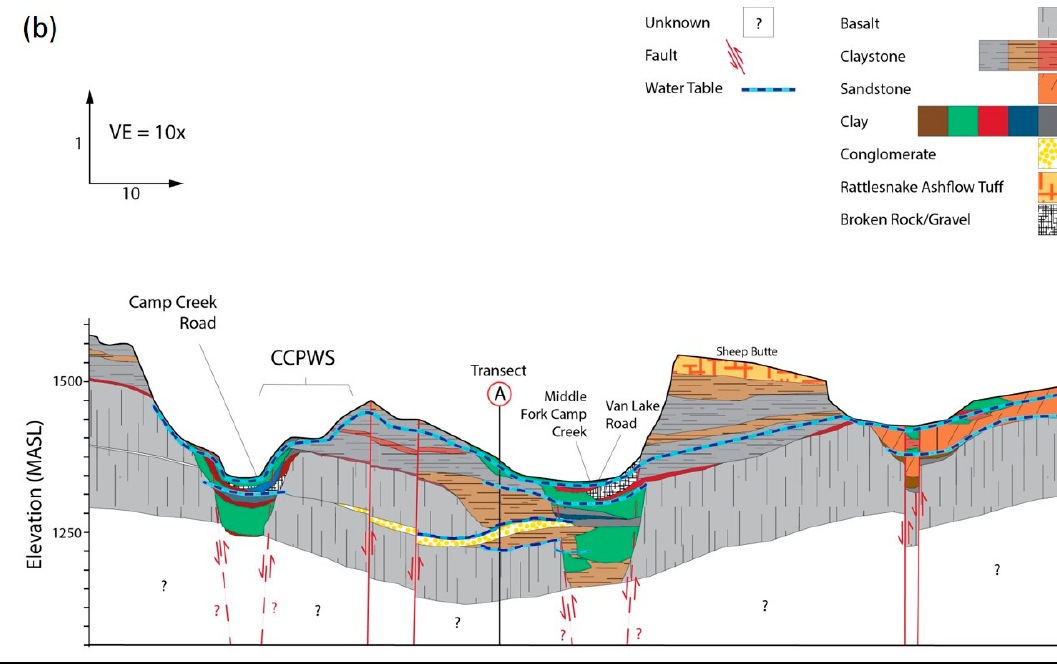
Figure 3. ( a ) Cross-section of the subsurface geology. Note the downward hydraulic gradient from the shallow sedimentary strata to the deeper basalt aquifer. ( b ) Cross-section of subsurface geology.